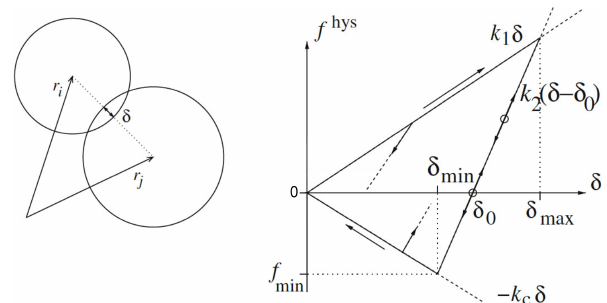
Figure 4. A schematic representation of the three phases of the con- tact law in normal